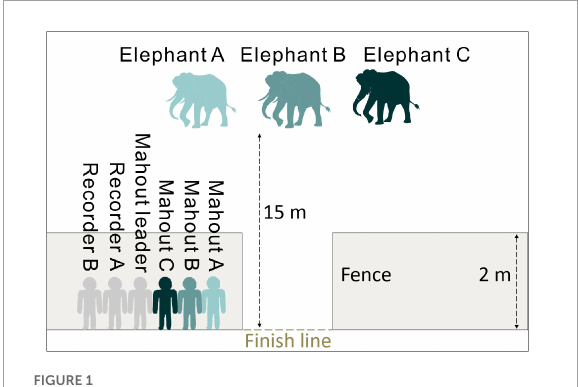
FIGURE1 Experiment set up for voice recognition in Asian elephant. Same color represents the matching elephants and